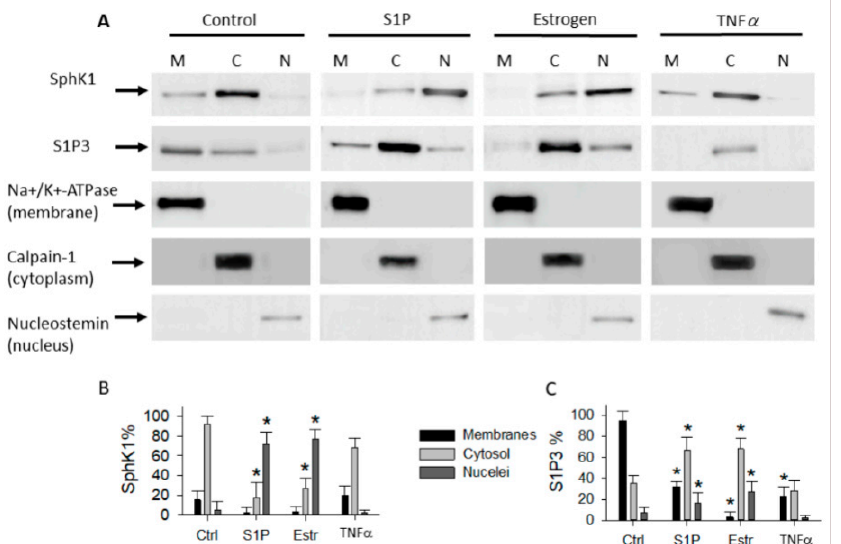
Figure 5. Immunoblot analysis of SphK1 and S1P3 localization in parental MCF-7 subcellular fractions. ( A ) Specific marker proteins were used to evaluate subcellular fractionation and gel loading: nucleostemin was used as marker for nuclear fraction (N), Na+/K+-ATPase for membrane fraction (M), and calpain-1 for cytoplasm fraction ( C ). Parental MCF-7 cells were treated as described in Figure 1. ( B ) Semi-quantitative analysis of SphK1 and S1P3 levels using gel densitometry. The SphK1 level in cytosol and S1P3 level in membranes of control cells were set as 100%. Results are the means of three independent experiments ± SD. Significance of the differences (* p < 0.05) was assessed between control and agent-induced effects. Images are representative of at least 3 independent